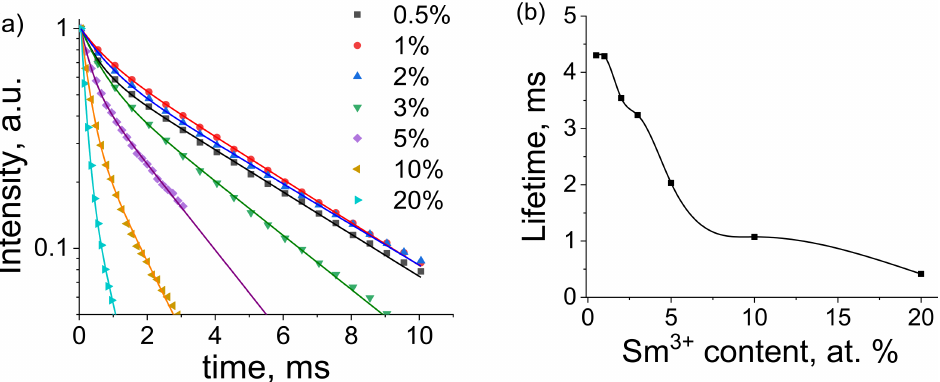
Figure 9. ( a ) Luminescence decay curves of NaY 1 − x Sm x F 4 phosphors monitored at 595 nm upon 400 nm excitation; and ( b ) doping concentration effect on 5 G 5/2 level lifetime. Experimental values and best biexponential fits are shown as dots and lines,